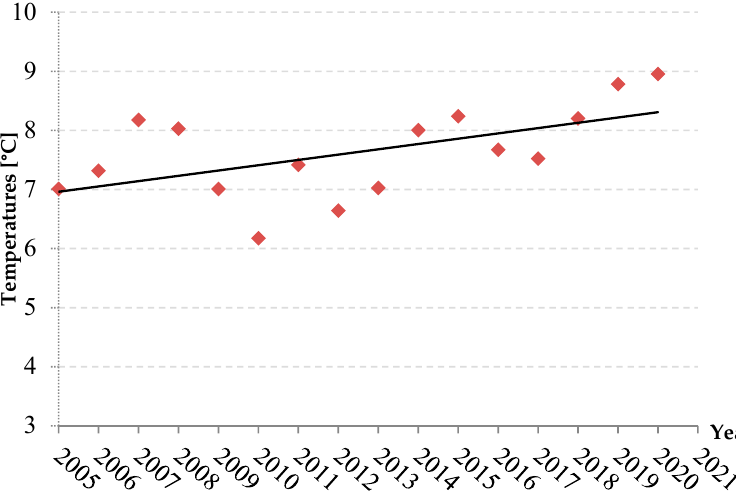
Figure 4. Changes in the average air temperature in the Go ł dap region in 2005–2021 in Poland, (source: own study based on IMWM data from 2005–2021 in Poland [27]).